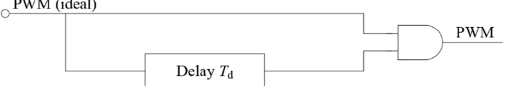
Figure 3. Switching angle trajectories when N = 9.